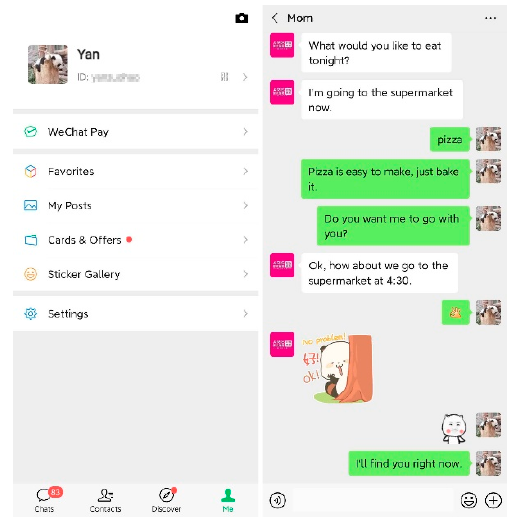
Figure 1. WeChat user ID and text communication (privacy information is blurred).